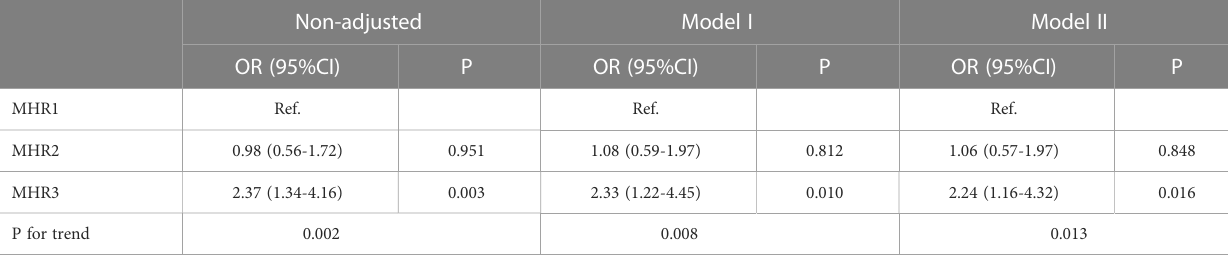
TABLE 4 Univariate and multivariate logistic analyses of AF in tri-sectional MHR groups.